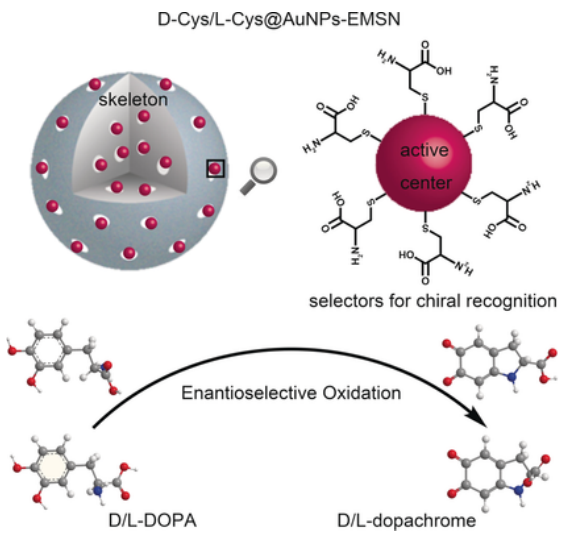
Figure 7. Scheme of the enantioselective D/L ‐ Cys@Au nanozyme. Reprinted with permission from [128]. Copyright © 2020 Wiley.